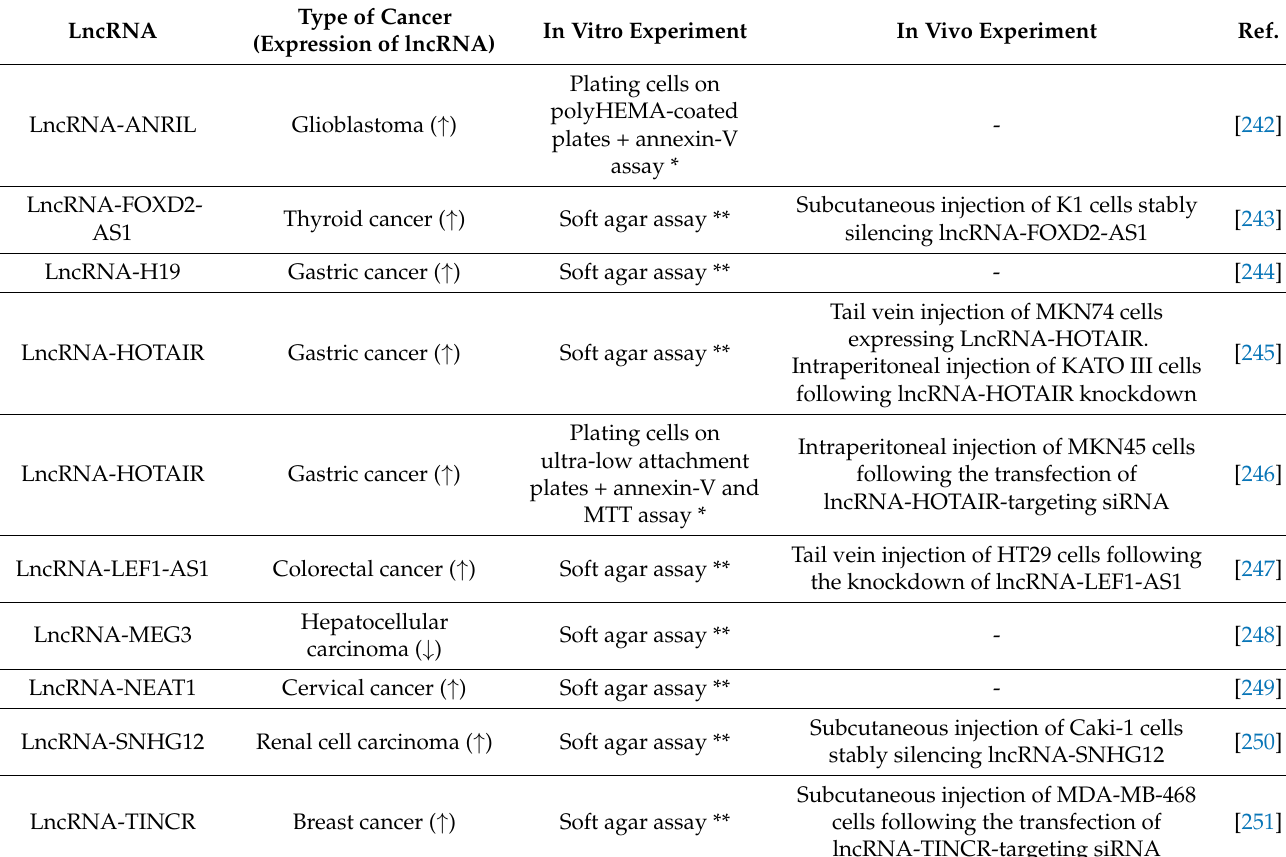
Table 3. LncRNAs that affect the anoikis resistance and anchorage-independent cell growth in